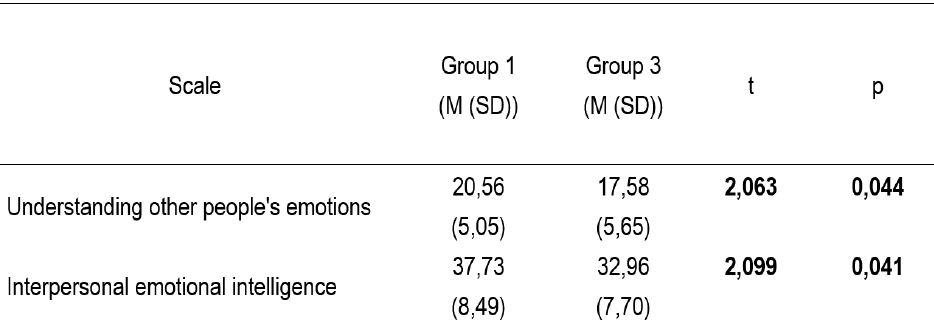
Indicators of emotional intelligence of mentors with average and low levels of